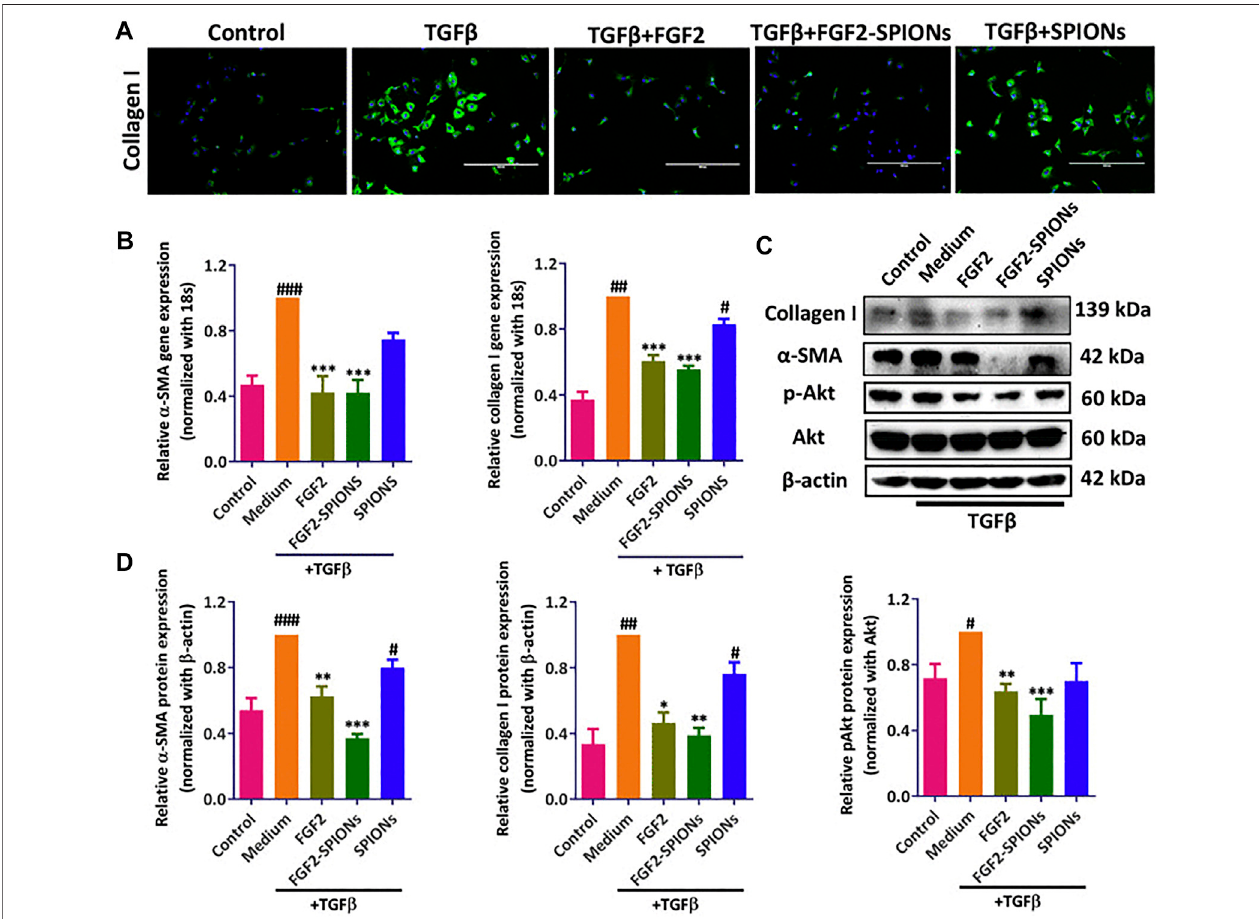
FIGURE 4 | Effects of FGF-2-conjugated SPIONs on HSC activation in vitro and in vivo . (A) Immuno fl uorescent detection of type-I collagen in control and TGF- β -stimulated LX2 cells in control, FGF-2-, FGF-2-SPION-, or SPION-treated groups. (B) Expression levels of a -SMA and type-I collagen in control, FGF-2-, FGF-2- SPION-, or SPION-treated groups. (C) Western-blot analysis of type-I collagen, pAkt, Akt, a -SMA, and ß -actin in control, FGF-2-, FGF-2-SPION-, or SPION-treated groups. (D) Quantitative analysis of Western-blot results. Reproduced under the terms and conditions of the Creative Commons Attribution 4.0